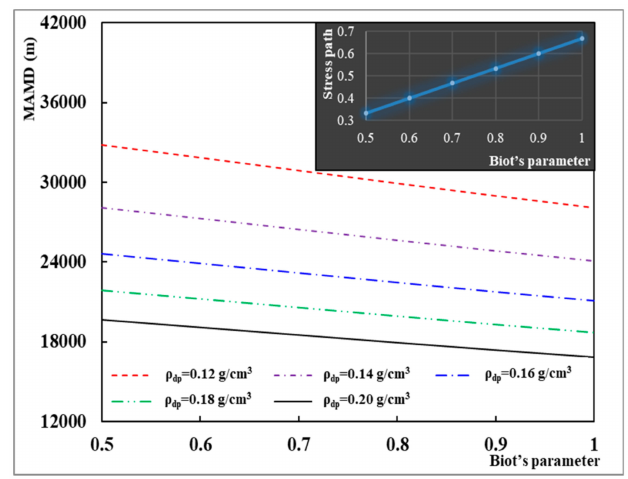
Figure 13. Effect of Biot’s parameter on the MAMD.